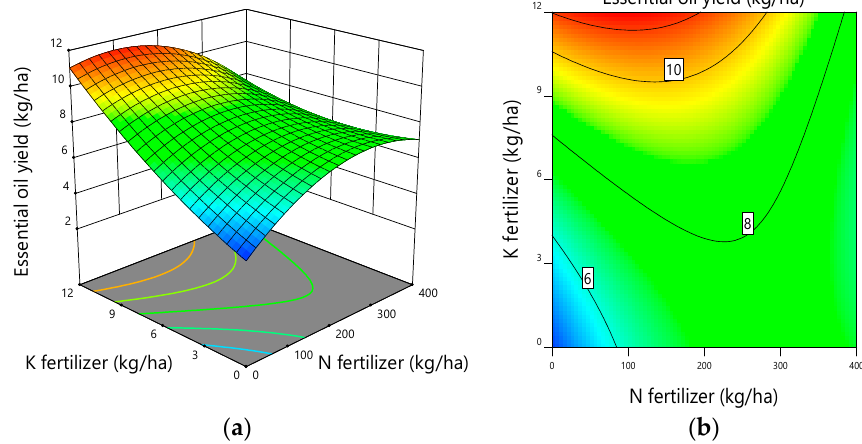
Figure 4. Response surface plots showing the interactive effects of N and K fertilizers ( a ), and K fertilizer and seaweed extract ( b ) on the essential oil content of thyme. Seaweed extract in ( a ), and